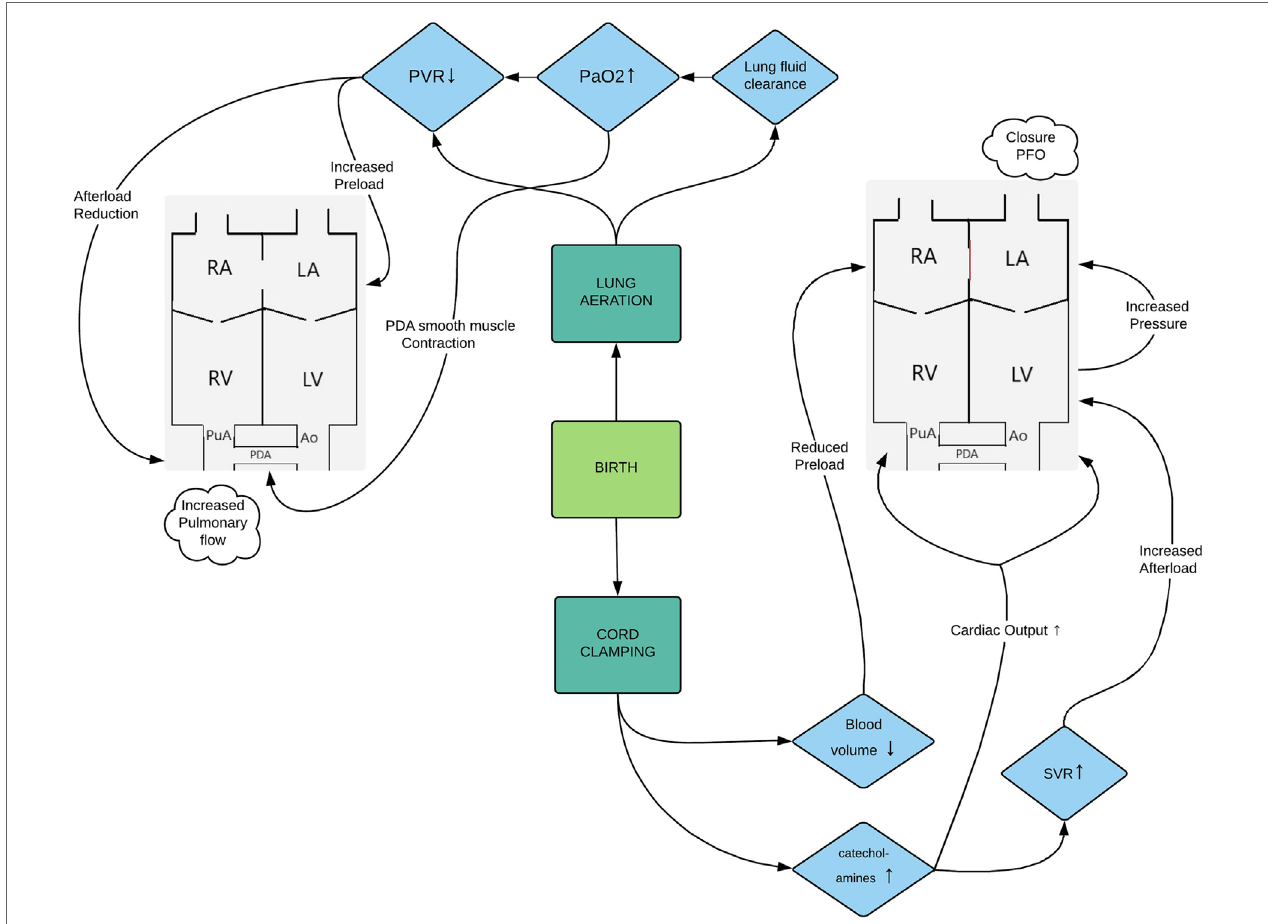
FiGURe 1 | Flowchart representing the hemodynamic changes during transition from intra-uterine to extra-uterine life. Abbreviations: Ao, aorta; LA, left atrium; LV, left ventricle; PaO 2 , partial arterial pressure of oxygen; PDA, patent ductus arteriosus; PFO, patent foramen ovale; PVR, pulmonary vascular resistance; PuA, pulmonary artery; RA, right atrium; RV, right ventricle; SVR, systemic vascular resistance.